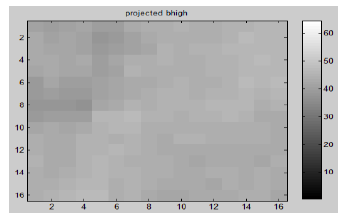
Figure 3b. Projected 16 ×16 pixels green channel